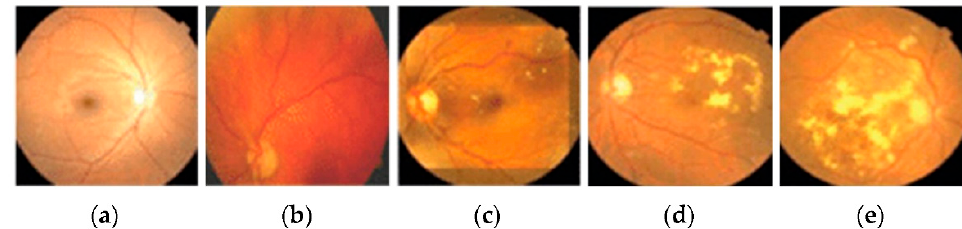
Figure 1. These images show the different types of retinopathies in the fundus images. ( a ) Normal, ( b ) mild, ( c ) moderate, ( d ) severe, and ( e ) proliferative.